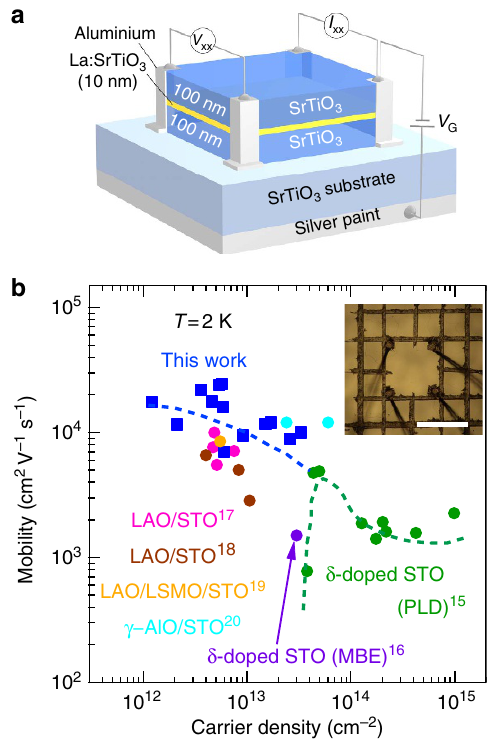
Figure 1 | Device structure and electron mobility in d -doped SrTiO 3 . ( a ) A sketch of a van der Pauw device with a back-gate electrode. ( b ) Electron mobility at 2K for various samples as a function of carrier density. The data in literatures 15–20 are also plotted for comparison. The inset shows an optical microscope image of the device defined by scratching. Scale bar, 500 m